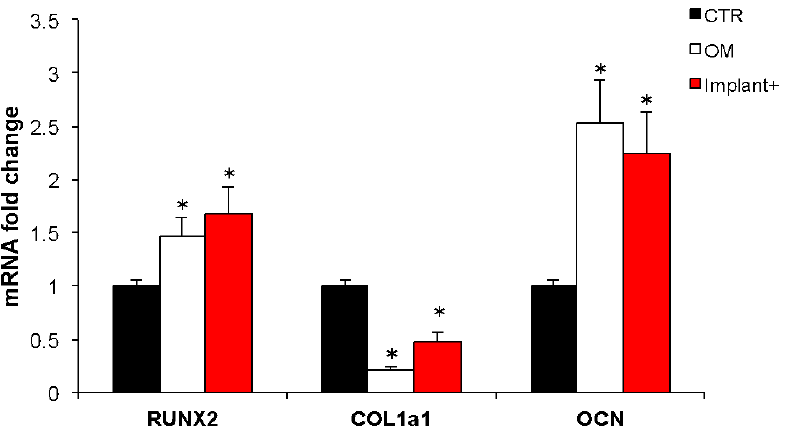
Figure 5. Effect of CGF-permeated implants on osteogenic gene expression. mRNA abundance of RUNX2, COL1a1, OCN in hBMSC cultured in basal medium (BM) (control, CTR), osteogenic medium (OM), BM + CGF-permeated implant (Implant+) for 21 days. Gapdh was used as a housekeeping gene for normalization. Fold change in mRNA expression was relative to CTR. The results were expressed as the means ± SD of triplicate measurements from three independent experiments (* p < 0.05 versus CTR).